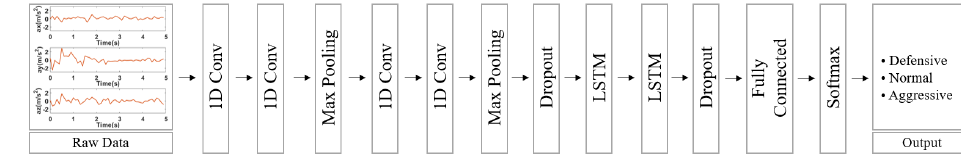
Figure 8. Four-layer CNN-2 stacked LSTM